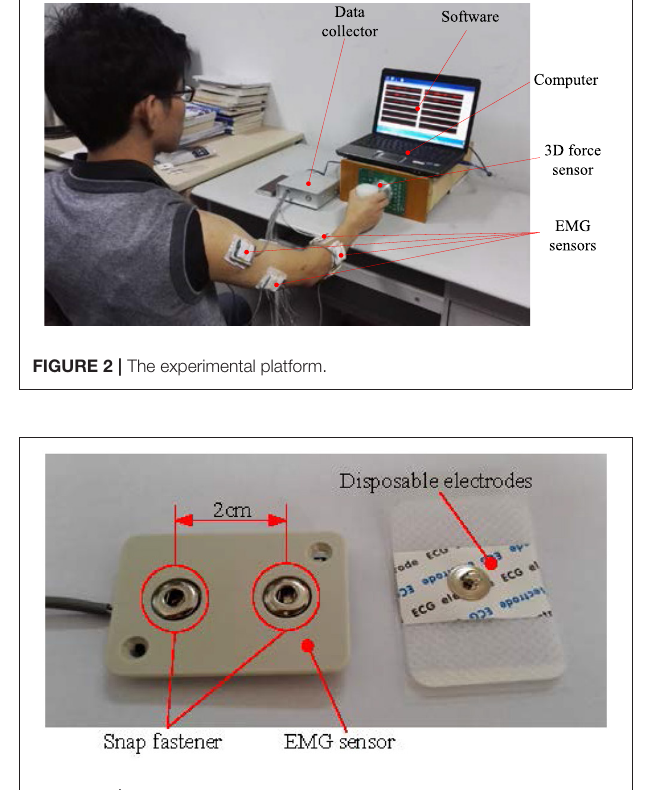
FIGURE 3 | The EMG sensor and disposable electrode.